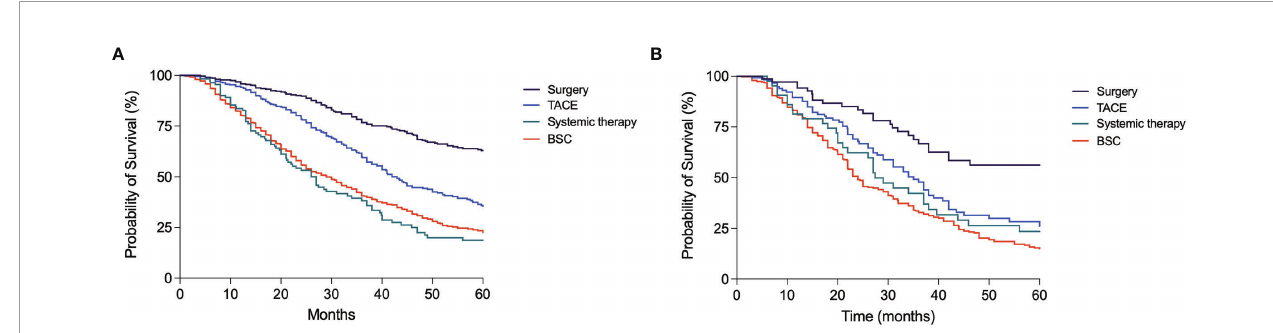
FIGURE 7 | Kaplan – Meier curves showing the survival of patients treated with TACE in fi rst-line according to the subsequent treatment. (A) In the overall patient population, those allocated to surgery had a signi fi cantly longer OS compared to those receiving another TACE (p < 0.0001); these latter patients had in turn a better prognosis compared to those allocated to systemic therapies (p < 0.0001) or BSC (p < 0.0001). (B) In BCLC B patients, those treated with surgery had a better prognosis compared to patients repeating a second course of TACE (p = 0.002); these latter had a similar survival compared to patients treated with systemic therapies (p = 0.44) but maintained a signi fi cantly longer survival compared to those allocated to BSC (p =